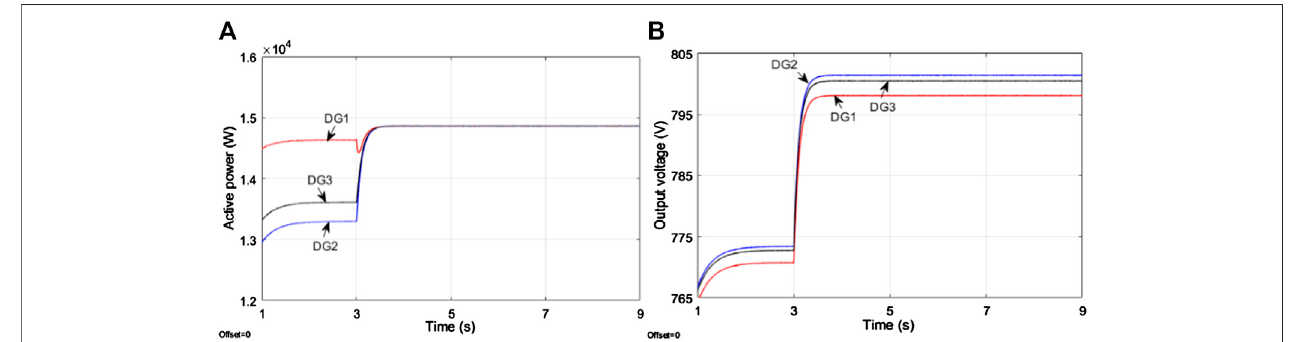
FIGURE 5 | Simulation results of active powers and actual output voltages with different communication delays and a fi xed input delay of τ (cid:1) 30 ms (A) τ ij (cid:1) 0 ms (B) τ ij (cid:1) 30 ms (C) τ ij (cid:1) 100 ms.